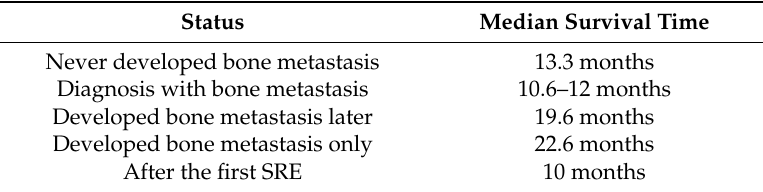
Table 1. Median survival time of RCC patients (Data from Ref.